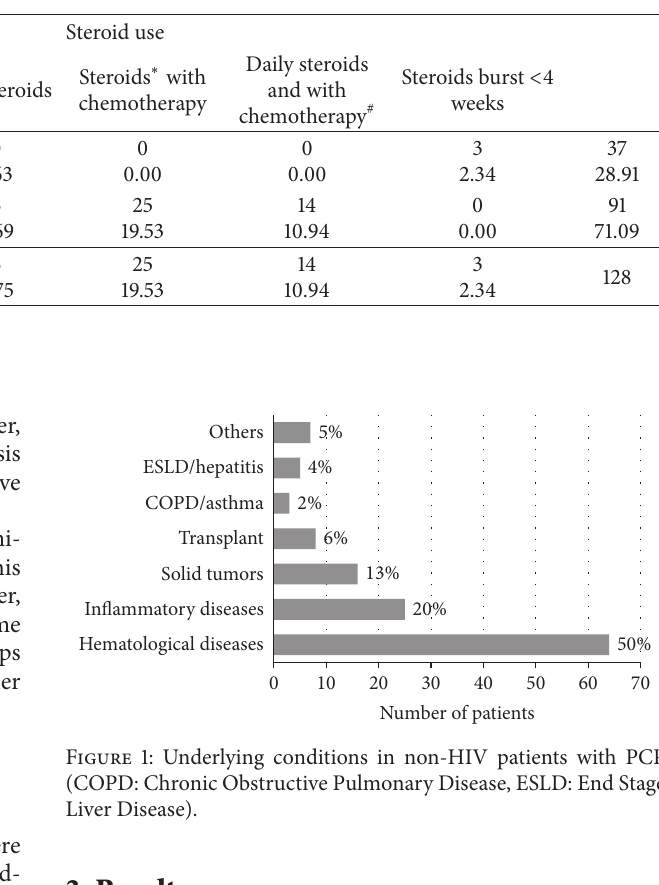
Table 1: Prior corticosteroid and immunosuppressant use in non-HIV patients with PCP.